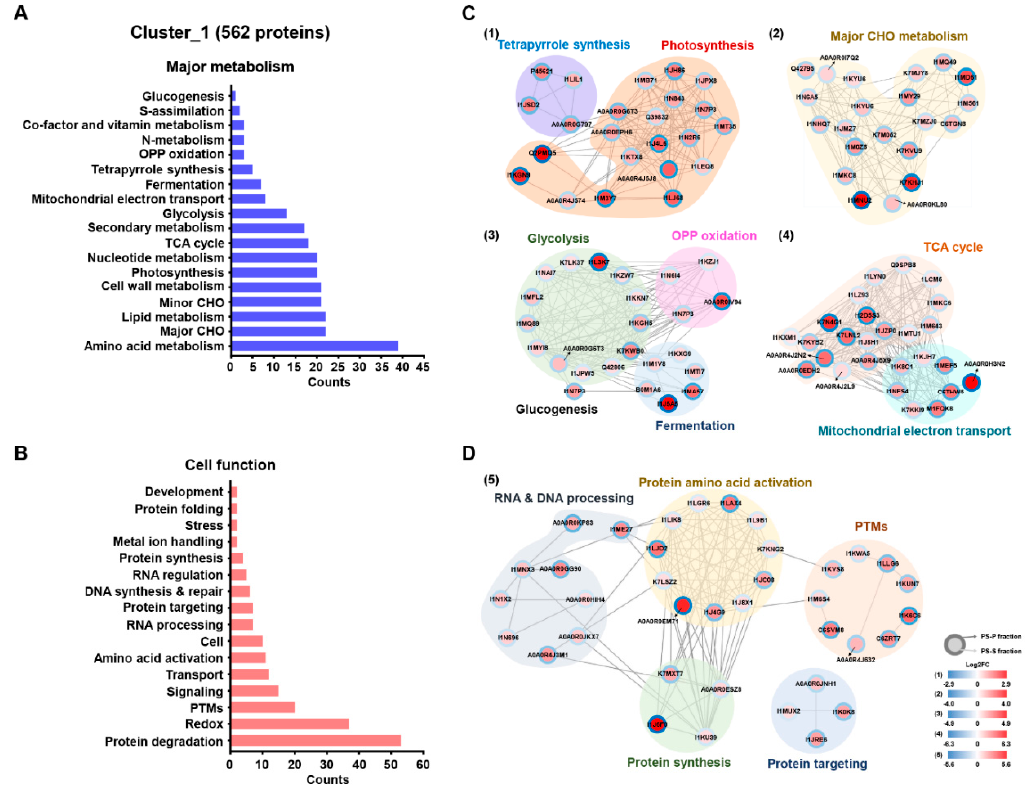
Figure 2. Functional classification of the identified and enriched proteins in cluster_1 using MapMan software. Differentially modulated proteins (with more than 1.5-fold change differences among each sample) were distinctly characterized as major metabolism overview ( A ) and cell function overview ( B ) categories. The abundance level of significant proteins involved in metabolism overview ( C ) and cell function overview ( D ) derived from the MapMan analysis showing the functional network with associated proteins. The fold change differences of individual proteins were visualized by colored nodes (red: increased abundance, blue: decreased abundance).